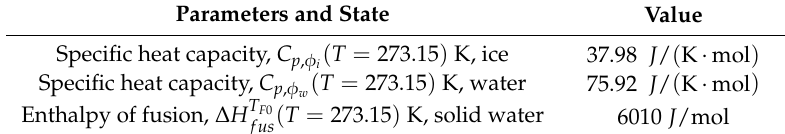
Table 1. Thermodynamic properties of pure water and methanol at 1 atm [18].